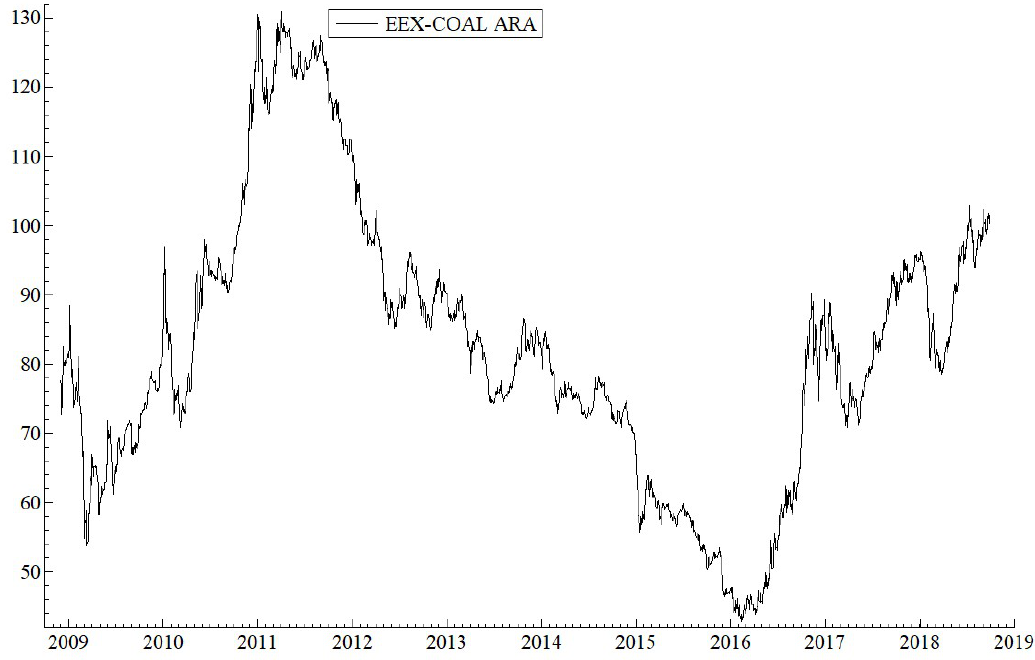
Figure 5. Daily prices in EEX Coal ARA futures in USD/ton, 2 December 2008 to 28 September 2018.